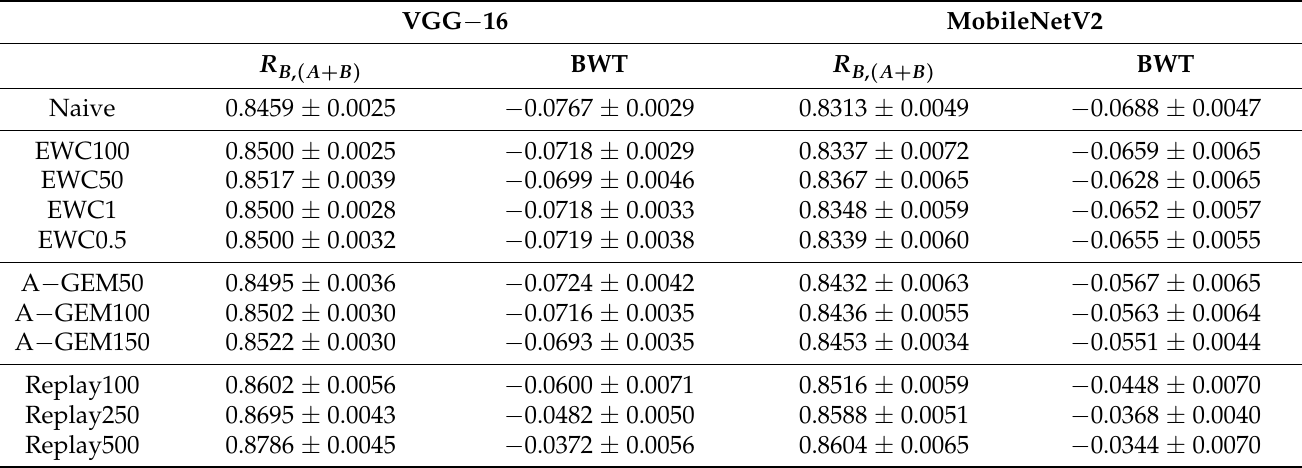
Table 4. Test results of the two models after training Task B considering different incremental learning strategies. Results averaged over 10 iterations ( ±